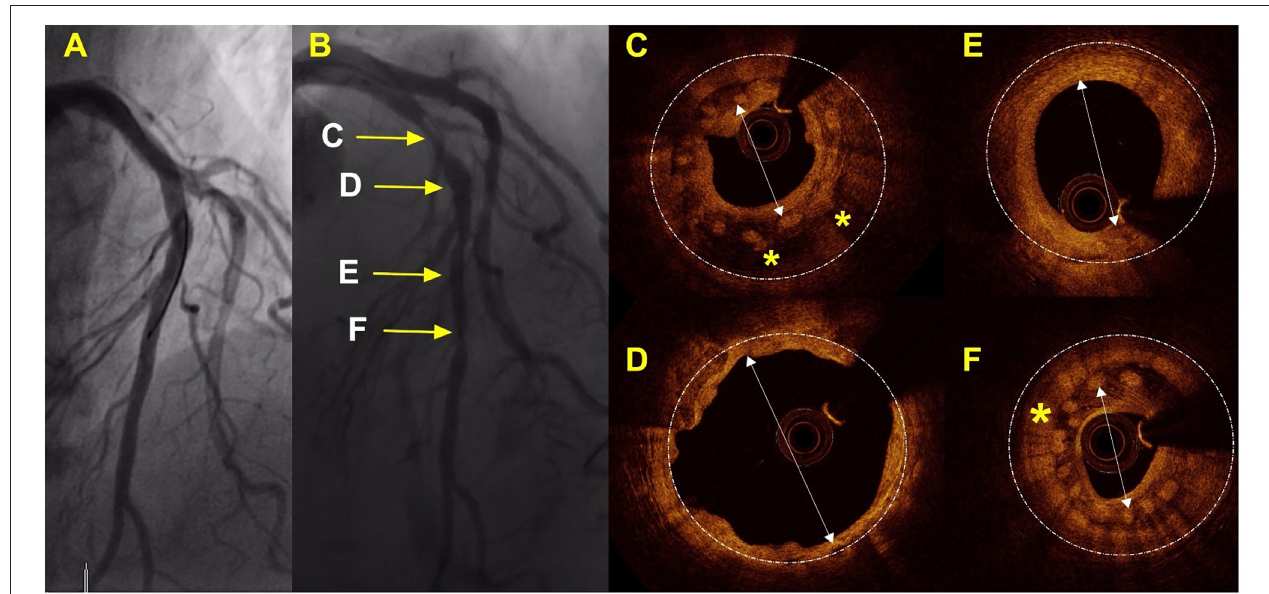
FIGURE 3 | Case with TLR 42 days after implantation of the 2 Mg-BRS. Angiographic and OCT results of a case that required TLR. (A) By angiographic measures, a good result was achieved after implantation of the 2 Mg-BRS devices to the left anterior coronary artery; (B) This shows the angiography of the left anterior descending artery 42 days after the scaffold implantation, including serial segments (C,E,F) with significant luminal narrowing [ > 75% by Quantitative Coronary Angiography (QCA)]; (C,F) These images illustrate device collapse and uncontrolled dismantling associated with excessive tissue formation and significant lumen loss; (D) This segment shows eccentric remodeling of the artery wall after complete degradation of the Mg-BRS; (E) On OCT, the Mg-BRS seems completed degraded in this segment of left anterior descending (LAD). Mg-BRS, magnesium-based sirolimus-eluting bioresorbable scaffold; OCT, optical coherence tomography. *: denotes the scaffold and arrow: denotes the vessel